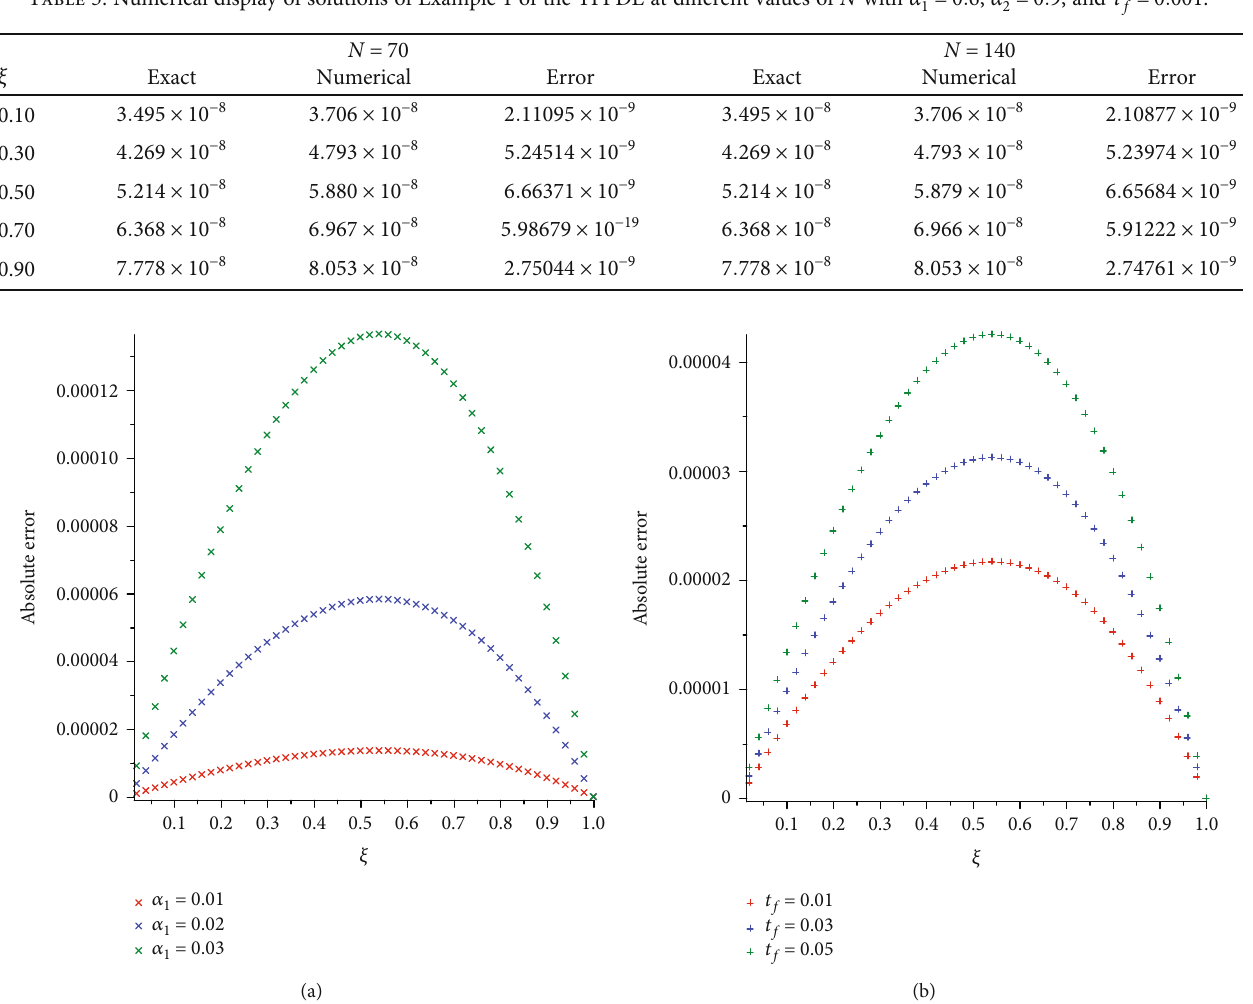
Table 5: Numerical display of solutions of Example 1 of the TFPDE at di ff erent values of N with α